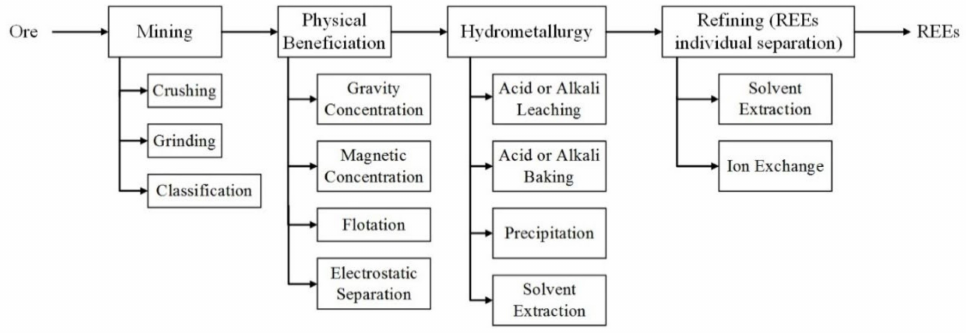
Figure 1. The REE general processing